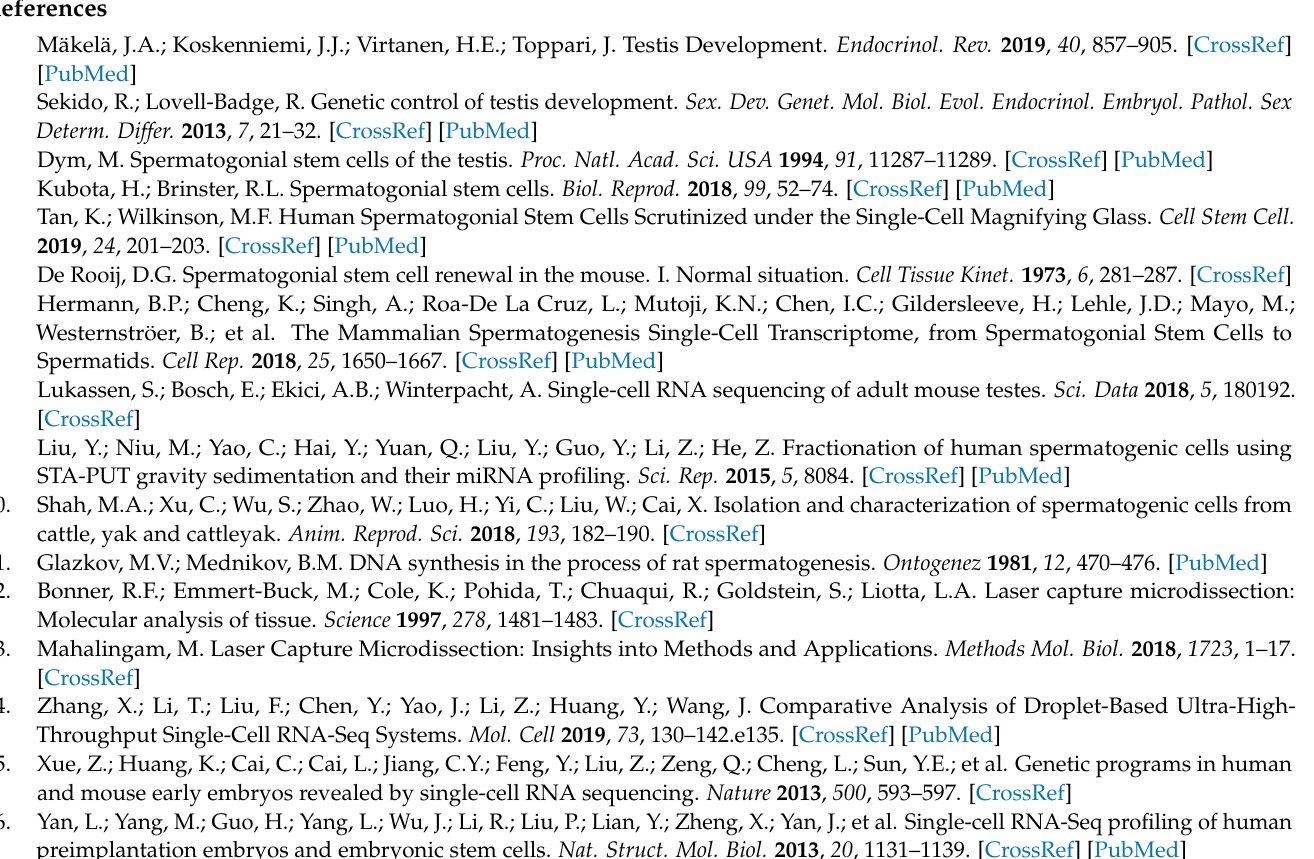
Ranger software; Table S3: The list of top 100 marker genes of each cell cluster; Table S4: The number of different cell types; Table S5: GO analysis of DEGs in each cell cluster by